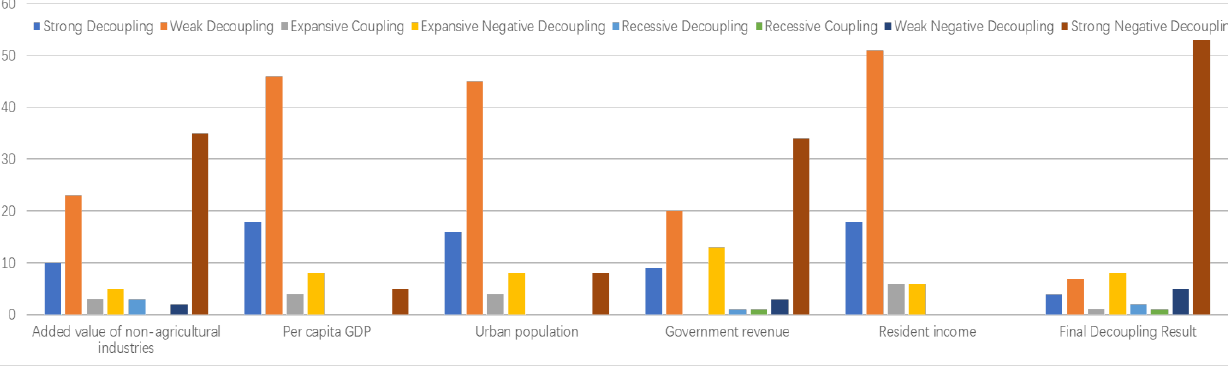
Figure 10. Spatial analysis on the decoupling relationship between urban construction land and added value of non-agricultural industries in Gansu. Per Capita GDP In terms of quantitative structure, cities in weak decoupling are the most numerous, followed by those in strong decoupling. There are no cities in recessive decoupling,